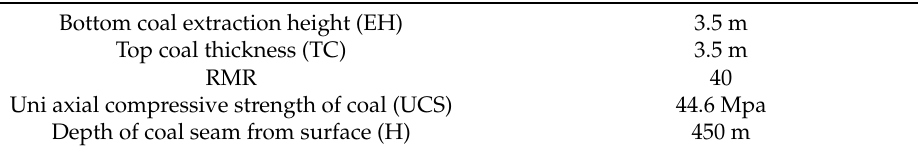
Table 6. Geo-mining conditions of ALP mine.